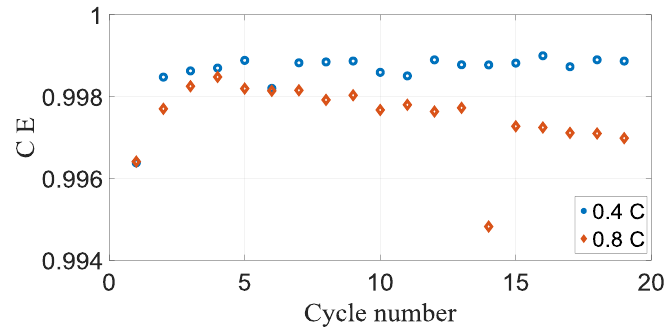
Figure 4. Coulombic efficiency vs cycle number.